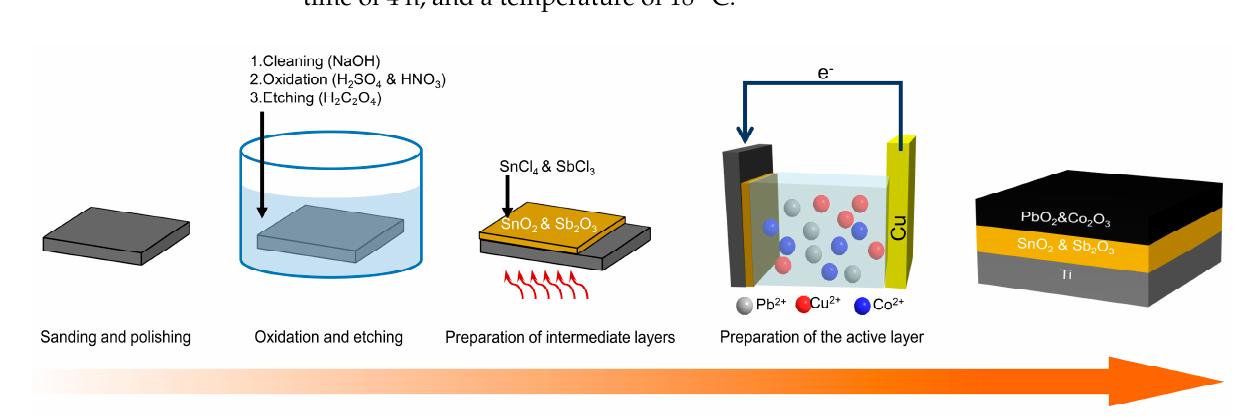
Figure 1. Ti/PbO 2 -Co electrode preparation process.